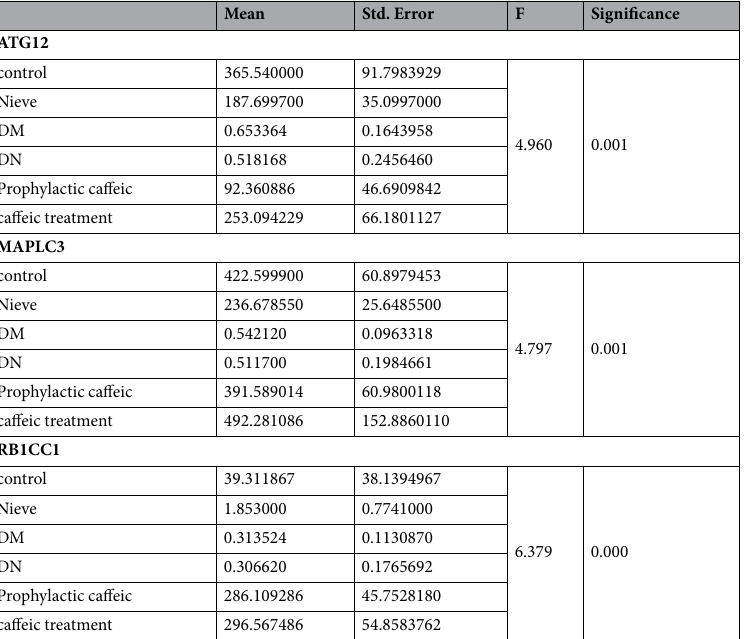
Table 2. Differential Expression of Autophagy transcript among different groups of animal model.